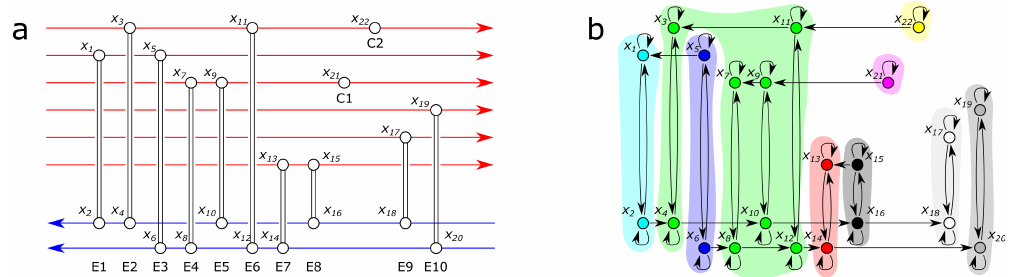
Figure 3. ( a ) the structure of the studied heat exchanger network represents how cold and hot streams influence each other; ( b ) the network representation of the state variables are related to the temperatures of the streams depicted in ( a ). Colors indicate strongly connected components.